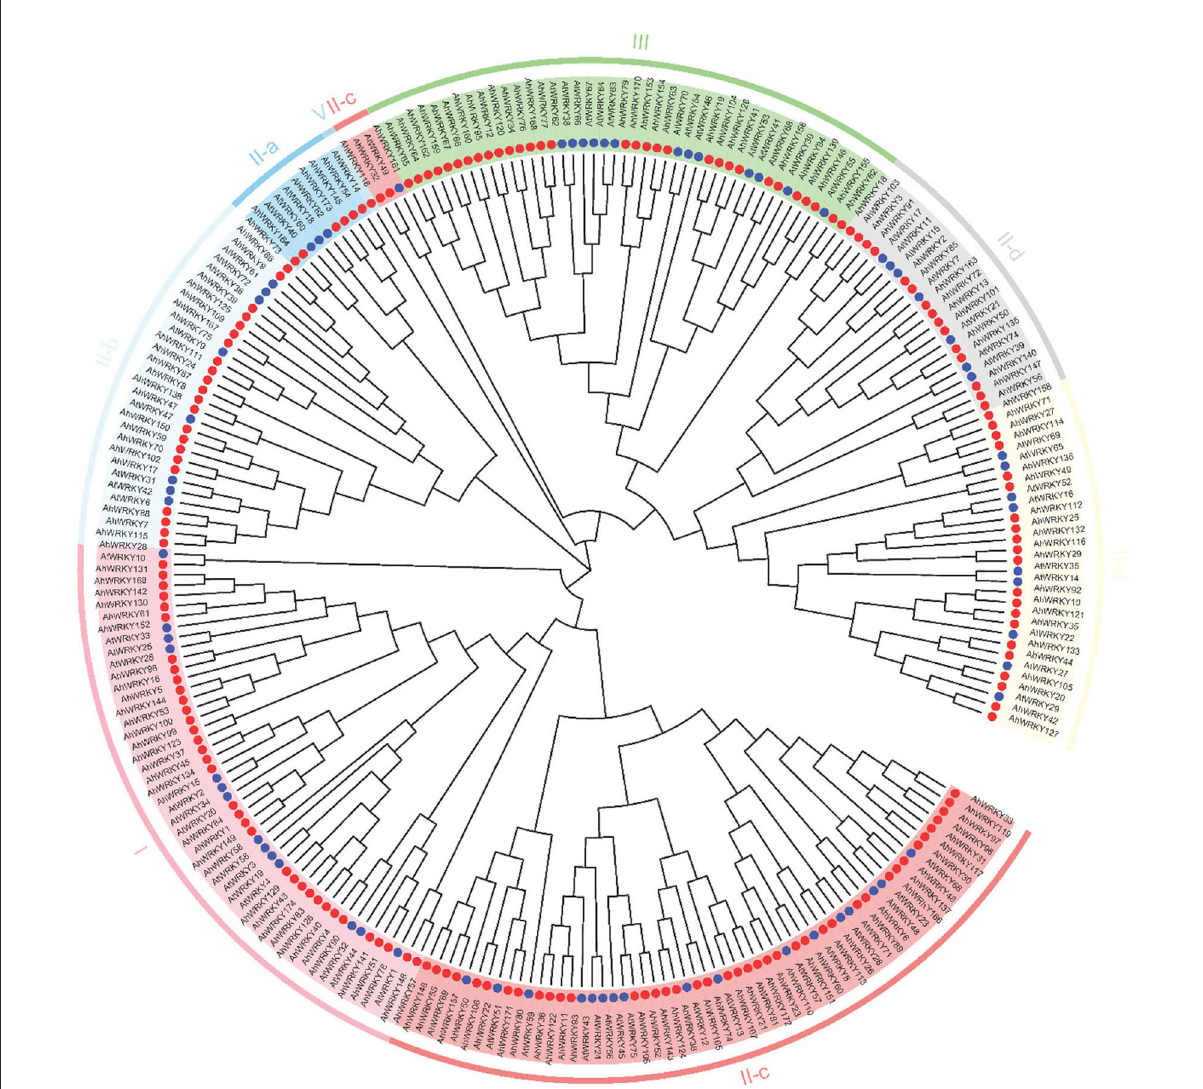
FIGURE1 Phylogenetic tree of WRKY in A. hypogaea cv. Tifrunner and Arabidopsis. All full-length protein sequences were aligned by MUSCLE, and the tree was generated using the neighbor-joining (NJ) method in MEGA7 software. Different colors indicated groups I, II-a, II-b, II-c, II-d, II-e, III, and IV subfamily WRKY proteins from peanuts. The blue and red circles indicate the Arabidopsis thaliana and A. hypogea